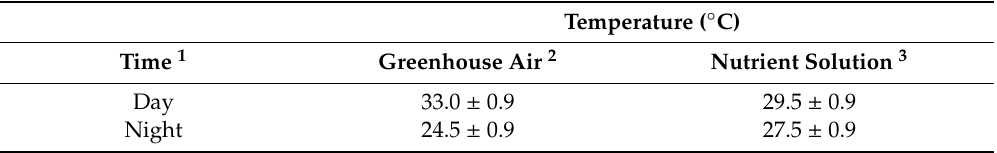
Table 2. Average temperatures during a lettuce heat tolerance trial conducted in deep water culture in a greenhouse from 30 June to 29 July and from 19 August to 19 September,